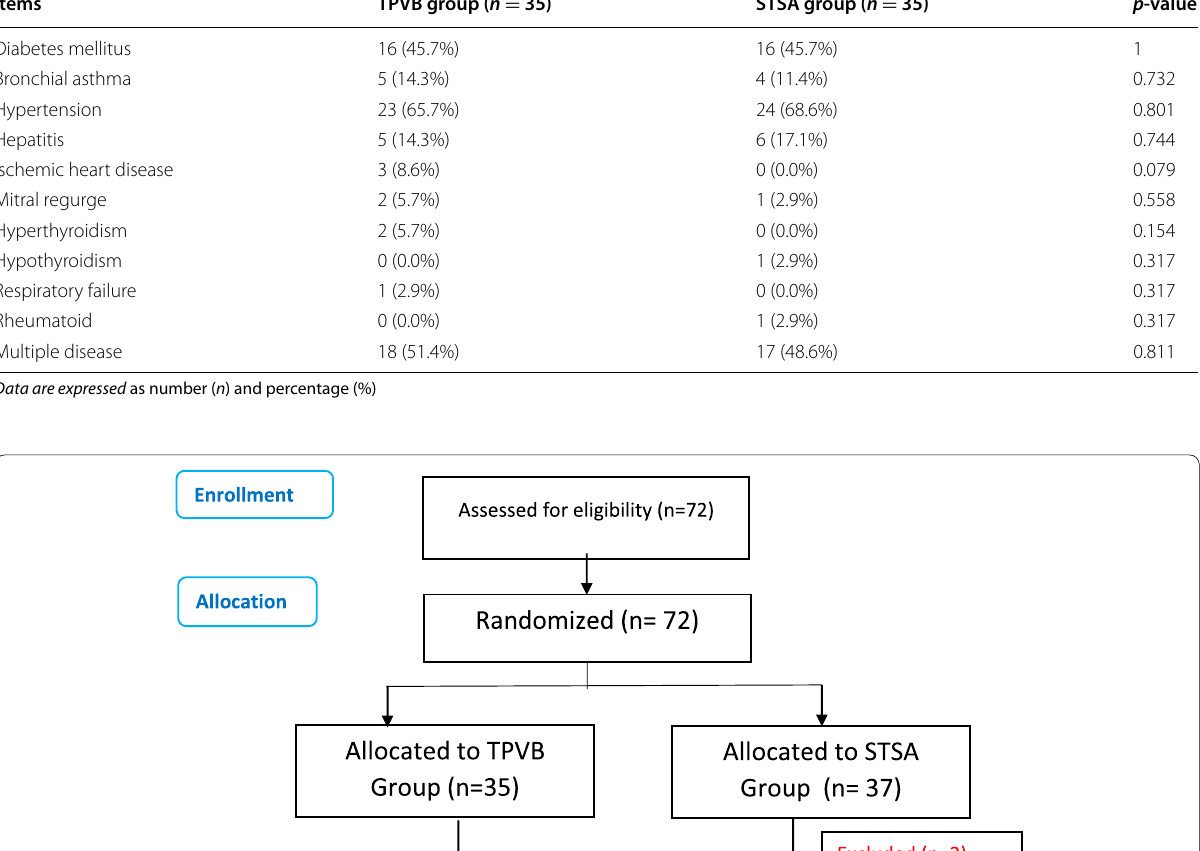
Table 2 Detailed coexisting diseases